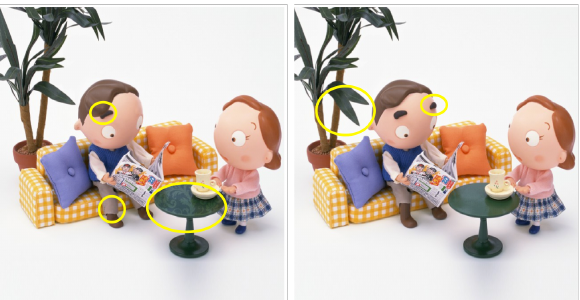
Figure 1. Example of the visual search task. Yellow circles indicate picture differences. Subjects were asked to identify and click on picture differences. For analysis, each image was divided into 25 areas of interest for a total of 50 per set. Time and location (x, y) of the clicks were rec- orded. Image from the app Picture Mania Deluxe by Raccoon Digital Technology Co